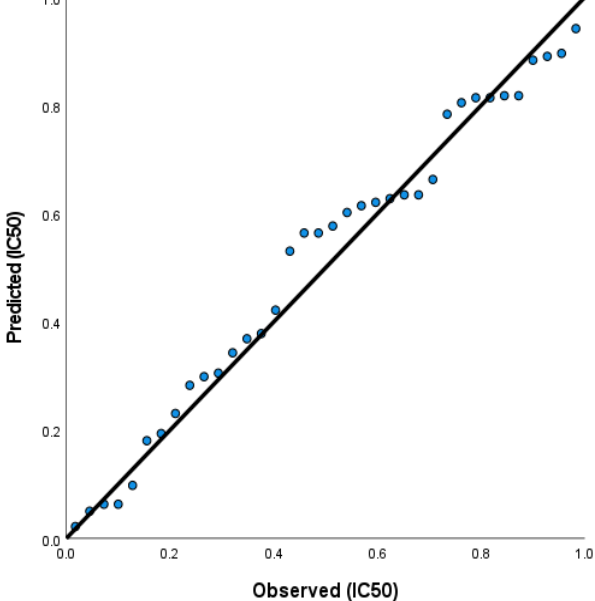
Figure 18. The first QSAR model was obtained by following regression equation IC50 = − 223 − 3.58 E LUMO + 11.55 χ , eV + 50.9 S, eV − 1 − 9.089 logP − 15.61 n rotb with r 2 , the correlation coefficient, r 2 = 0.9682.